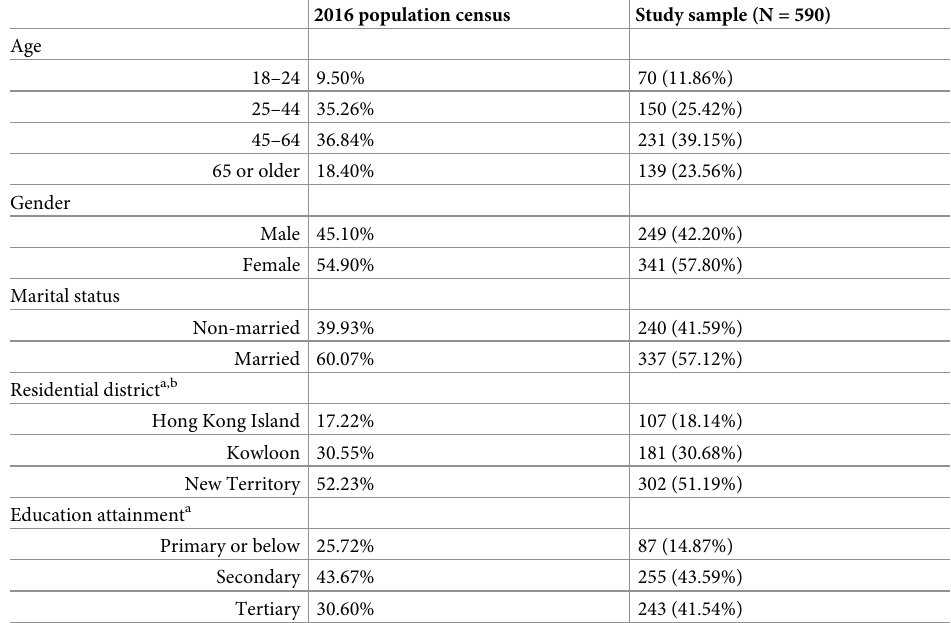
Table 1. The respondent population details and the comparison with Census population